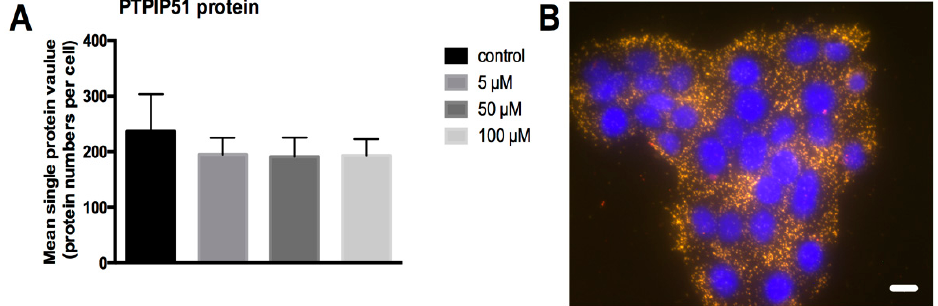
Figure 4. Quantification of total PTPIP51 molecules. ( A ) PTPIP51 protein per cell as determined by Duolink proximity ligation assay (DPLA) using two proximity ligation assay (PLA) probes (plus and minus) both directed against the PTPIP51 antibody in untreated HaCaT cells and cells treated for 24